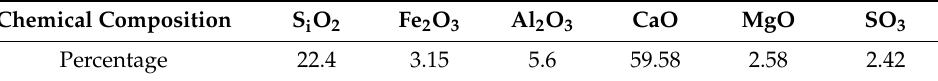
Table 1. Chemical composition of OPC.